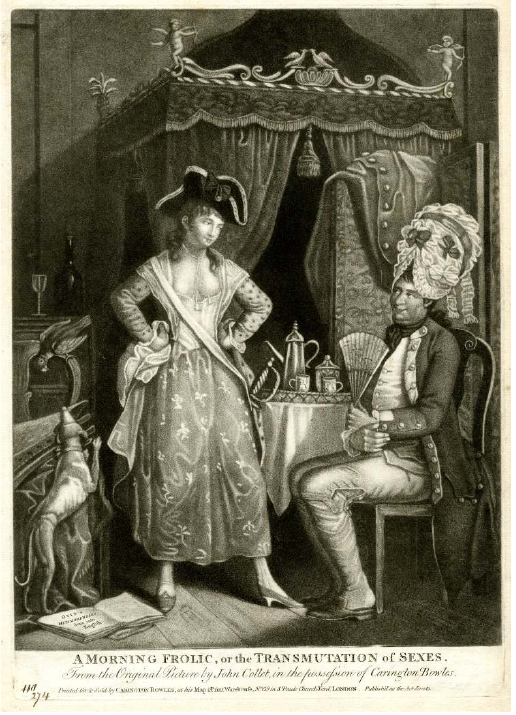
This graphic interlude features a selection of photographs which can illustrate the topic of this issue: “Unstable states, mutable